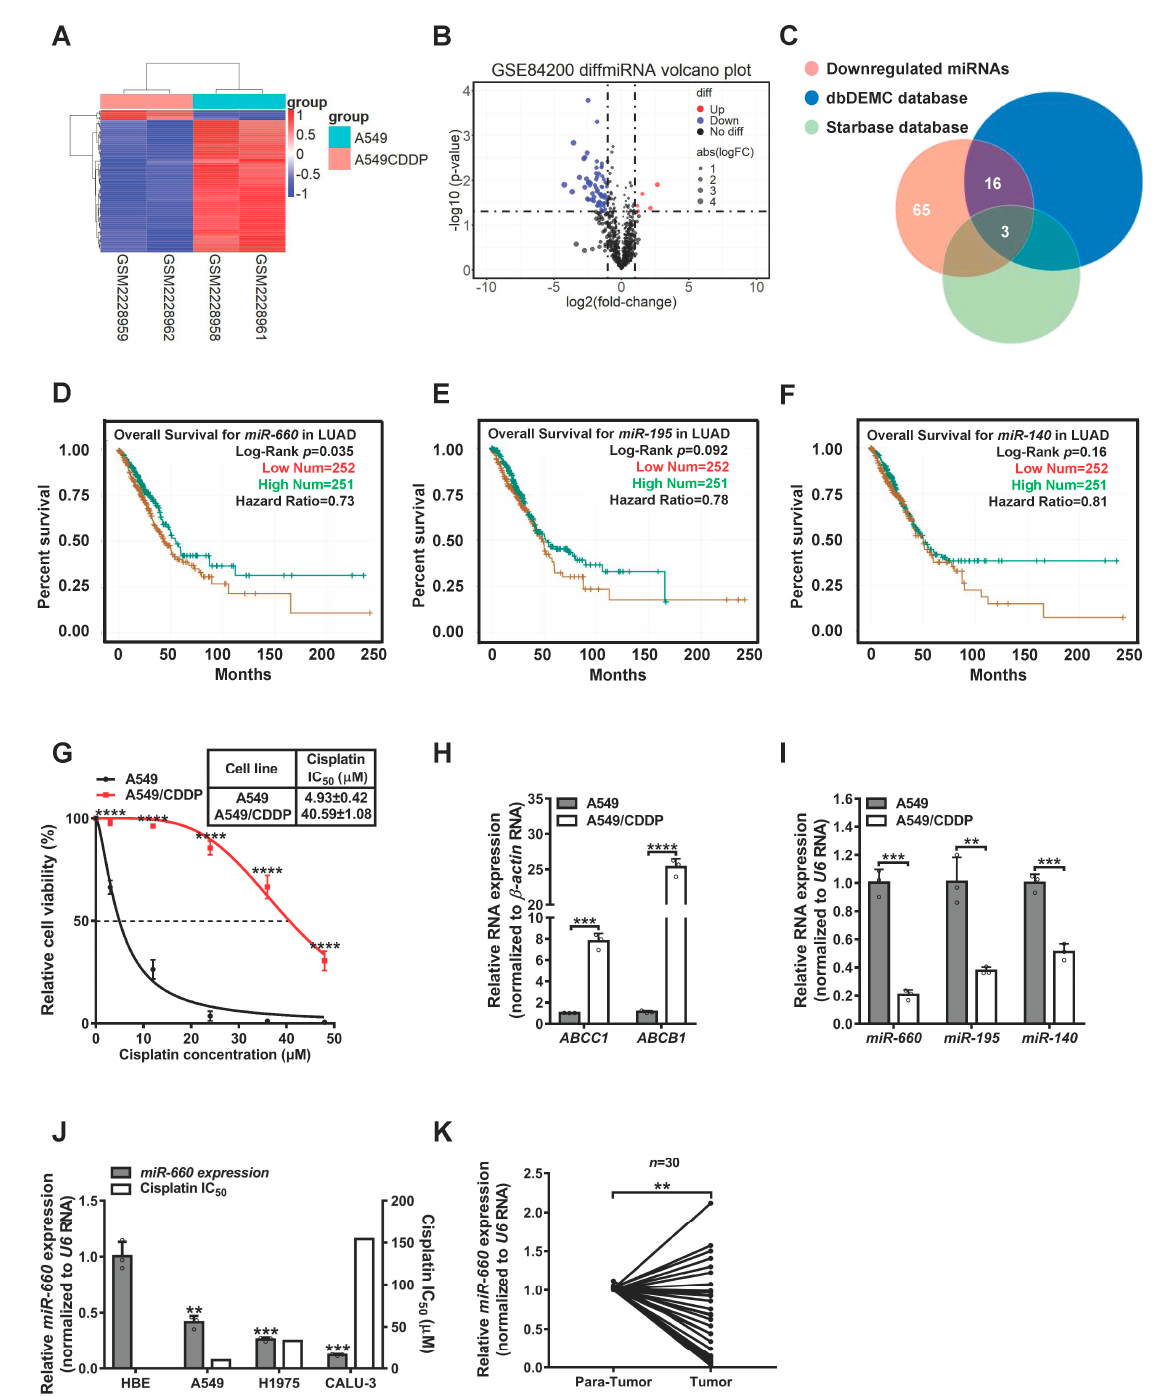
Figure 1. MiR - 660 expression is associated with cisplatin sensitivity in LUAD cells. ( A , B ) Heatmap and Volcano plot of the miRNA differential analysis using the GSE84200 dataset. ( C ) Venn diagram showing the intersection of miRNAs’ low expression in A549/CDDP cells, downregulated in tumor tissues with good prognosis in LUAD patients. ( D – F ) The relationship between miR - 660 , miR - 140, and miR - 195 expression and prognosis of LUAD patients, according to the starbase database. ( G ) Cisplatin IC 50 values of A549 and A549/CDDP cells. ( H ) The expression levels of two drug resistance markers, including ABCC1 and ABCB1 , in A549 and A549/CDDP cells were de-